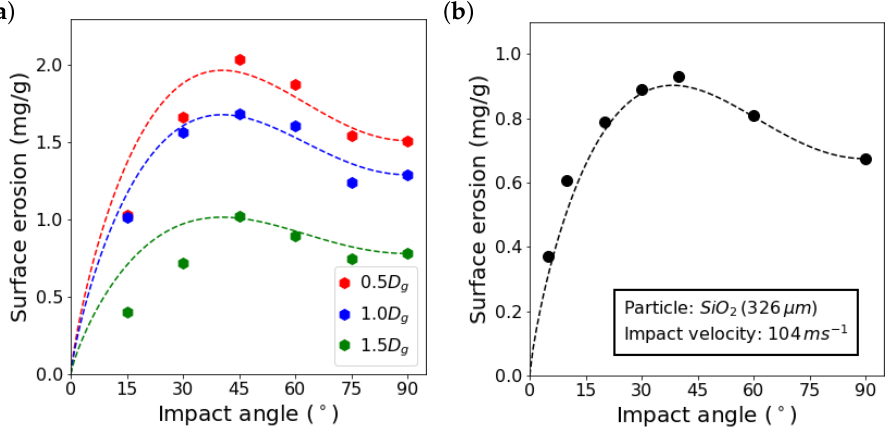
Figure 11. ( a ) Surface erosion as a function of the impact angle for three different ranges of grain center distributions; dots are the calculated erosions and dashed lines are the predictions obtained by Oka’s erosion model. ( b ) Surface erosion of stainless steel AISI 304 obtained by blasting tests reported by Oka et al.